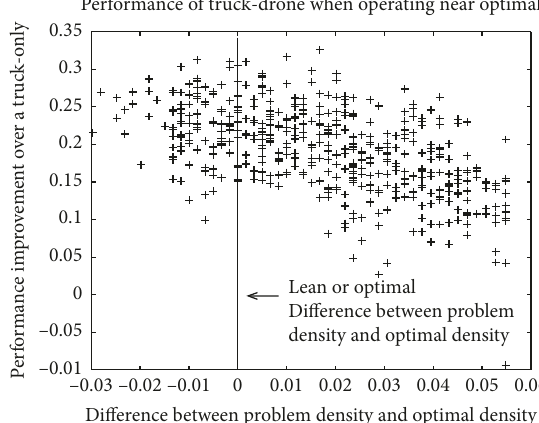
Figure 4: Percent improvement Π over truck-only time as ρ ∗ moves toward optimal density ρ opt